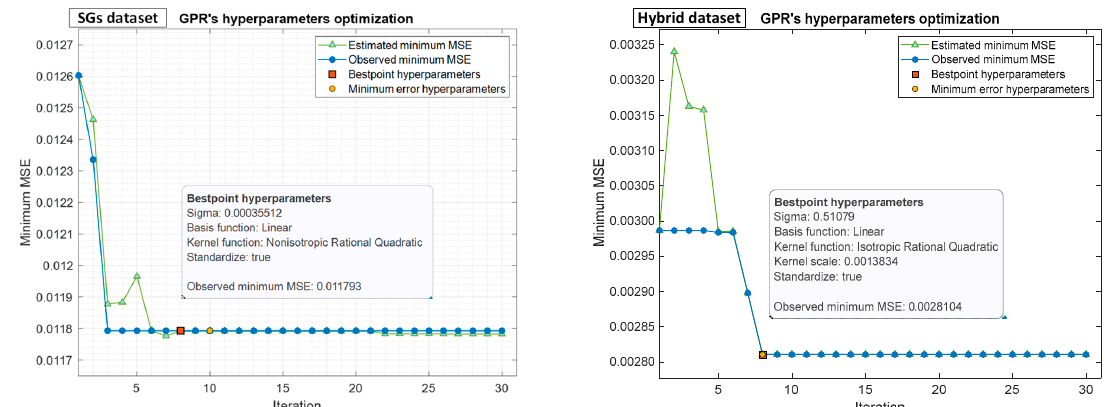
Figure 14. Minimum MSE plots for GPR method in both experimental and hybrid datasets, which were updated by Bayesian optimization runs.